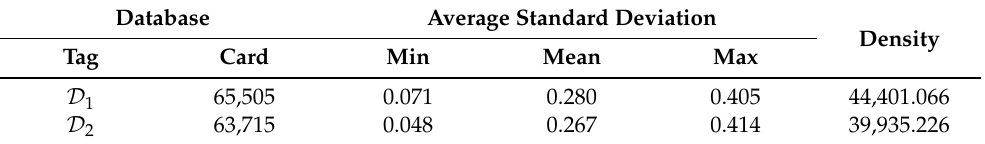
Table 2. AvStd and density of the two